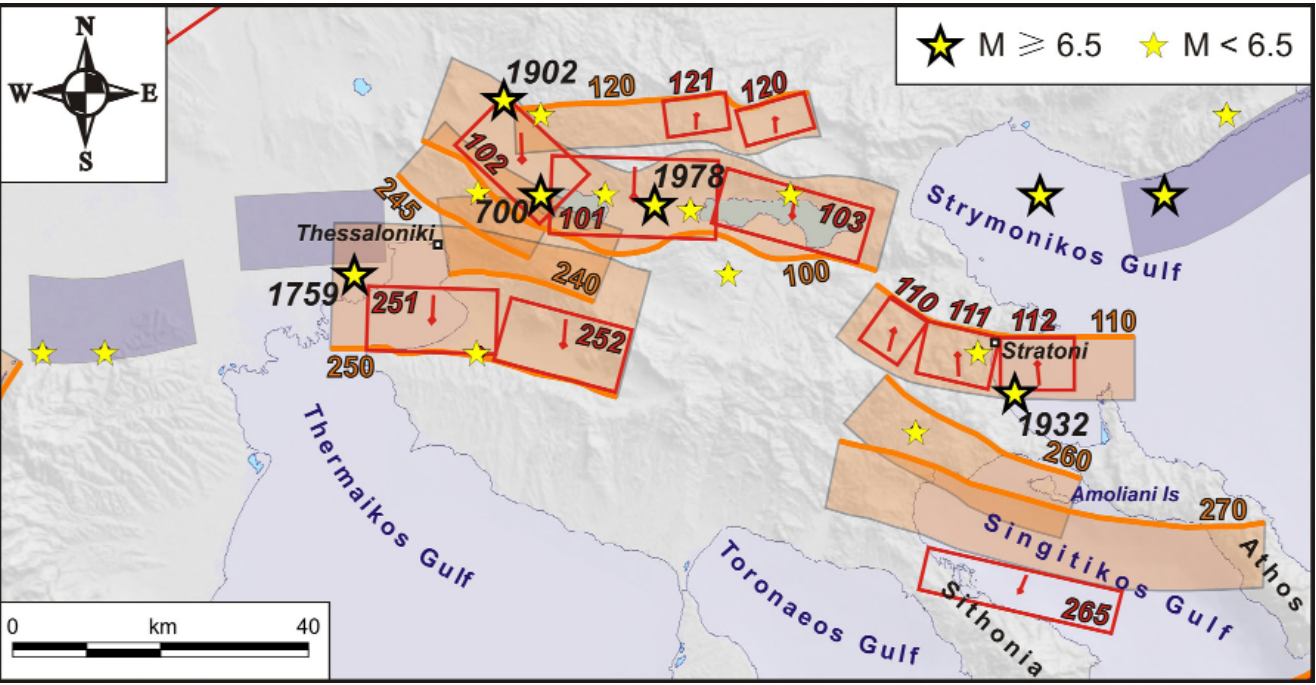
Figure 4. Map detail of the seismogenic sources belonging to the "Chalkidiki fault system". See Figure 1 for map location and seismogenic sources. Three-digit labels refer to the database code of the seismogenic source (ISS codes in italics). Years are provided for major earthquakes discussed in the main text (see also Table